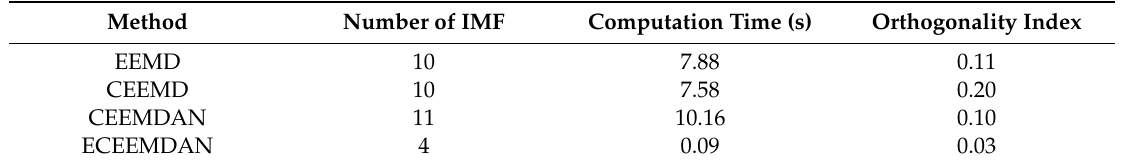
Table 1. Comparison of the decomposition e ff ect.